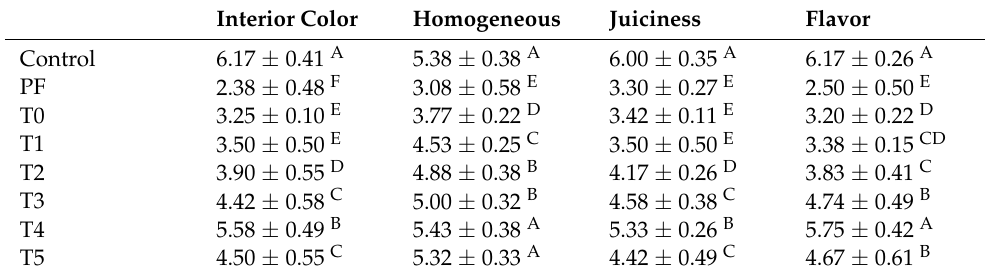
Table 9. Sensory evaluation of phosphate-containing frankfurters or phosphate-free frankfurters added with the combination of L-Arg and